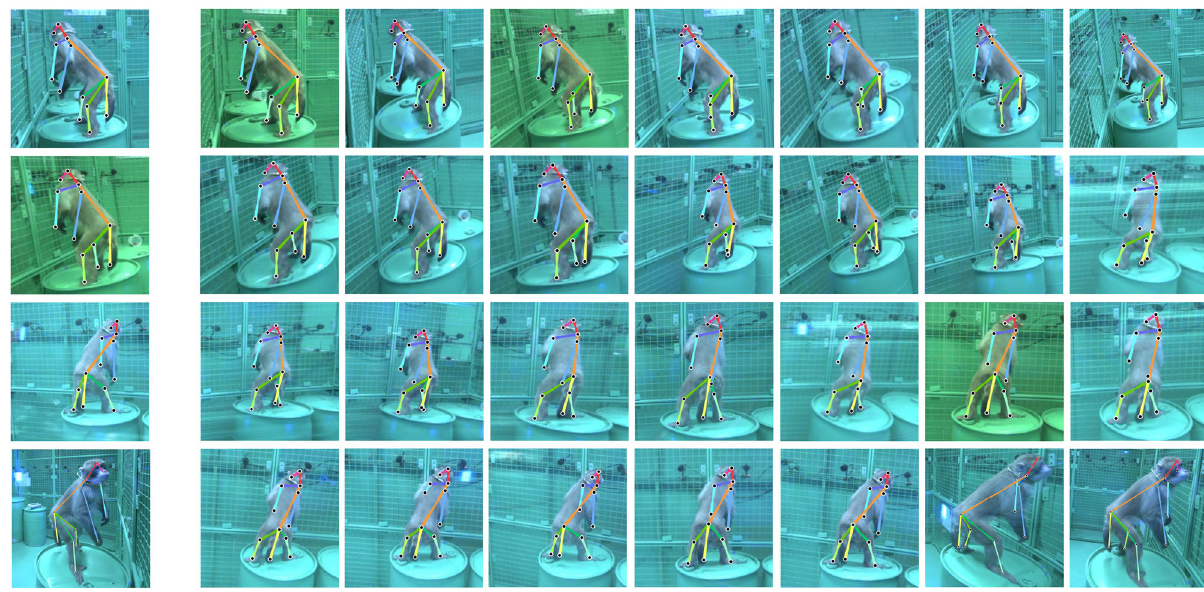
Fig. 9 Multiview augmentation. OpenMonkeyStudio leverages multiview geometry to augment the annotated data across views. The three images in the left most column are manually annotated and the 2D pose of the rest images are automatically augmented by 3D reconstruction and its